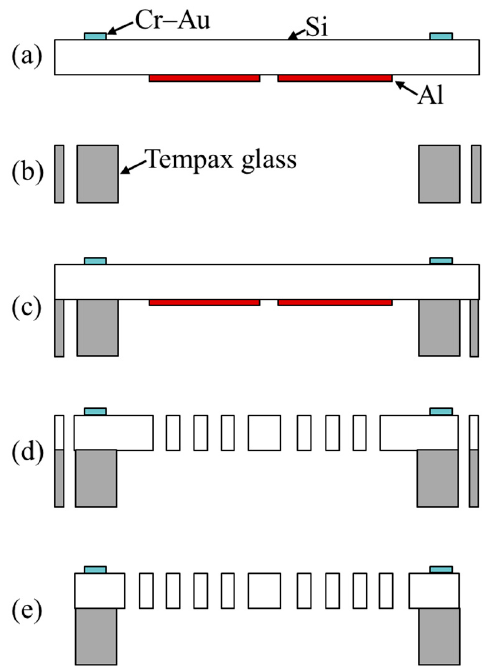
Figure 3. Microfabrication process of the comb-drive actuator based on the heterogeneous substrate of Si anodically bonded onto glass: ( a ) sputter metal layers and lift-off; ( b ) sandblast etching of Tempax glass; ( c ) anodic bonding of Si with glass; ( d ) deep RIE of Si and wet etching of Al; ( e ) YAG-laser cutting of support beams and supercritical drier.